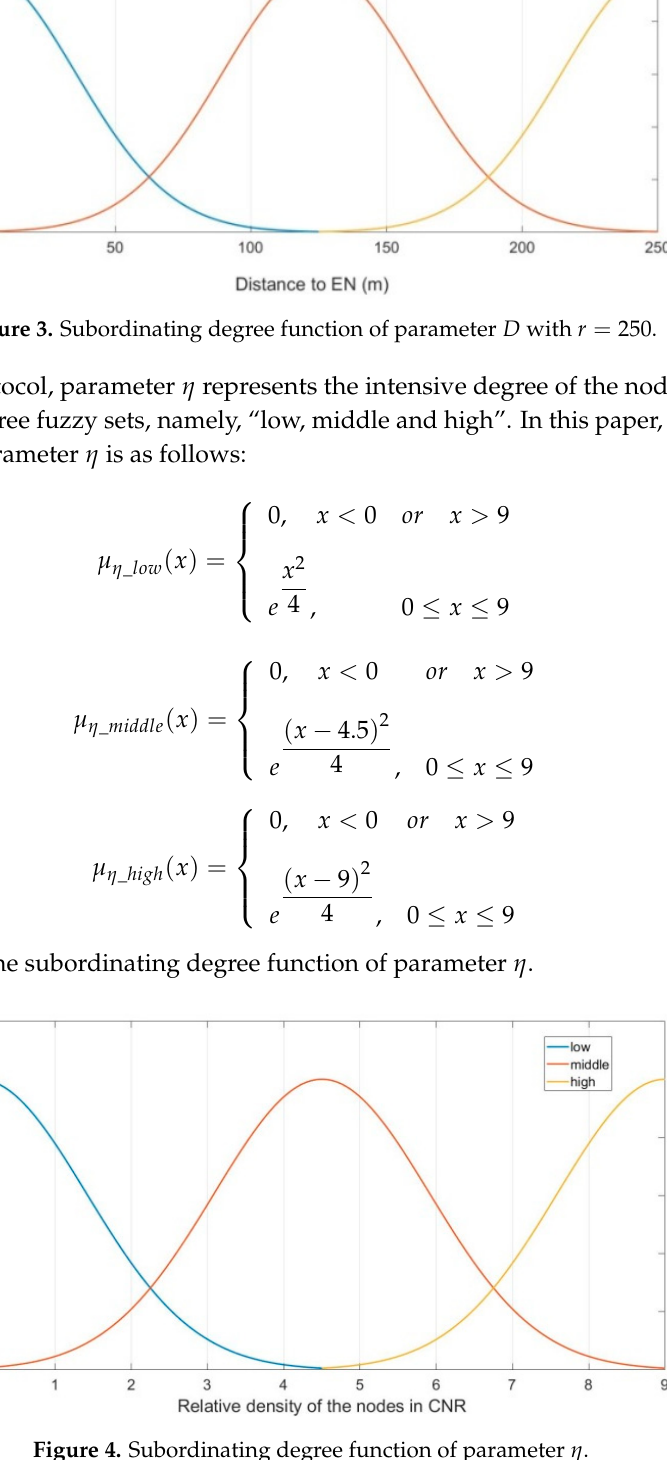
Figure 4. Subordinating degree function of parameter η .